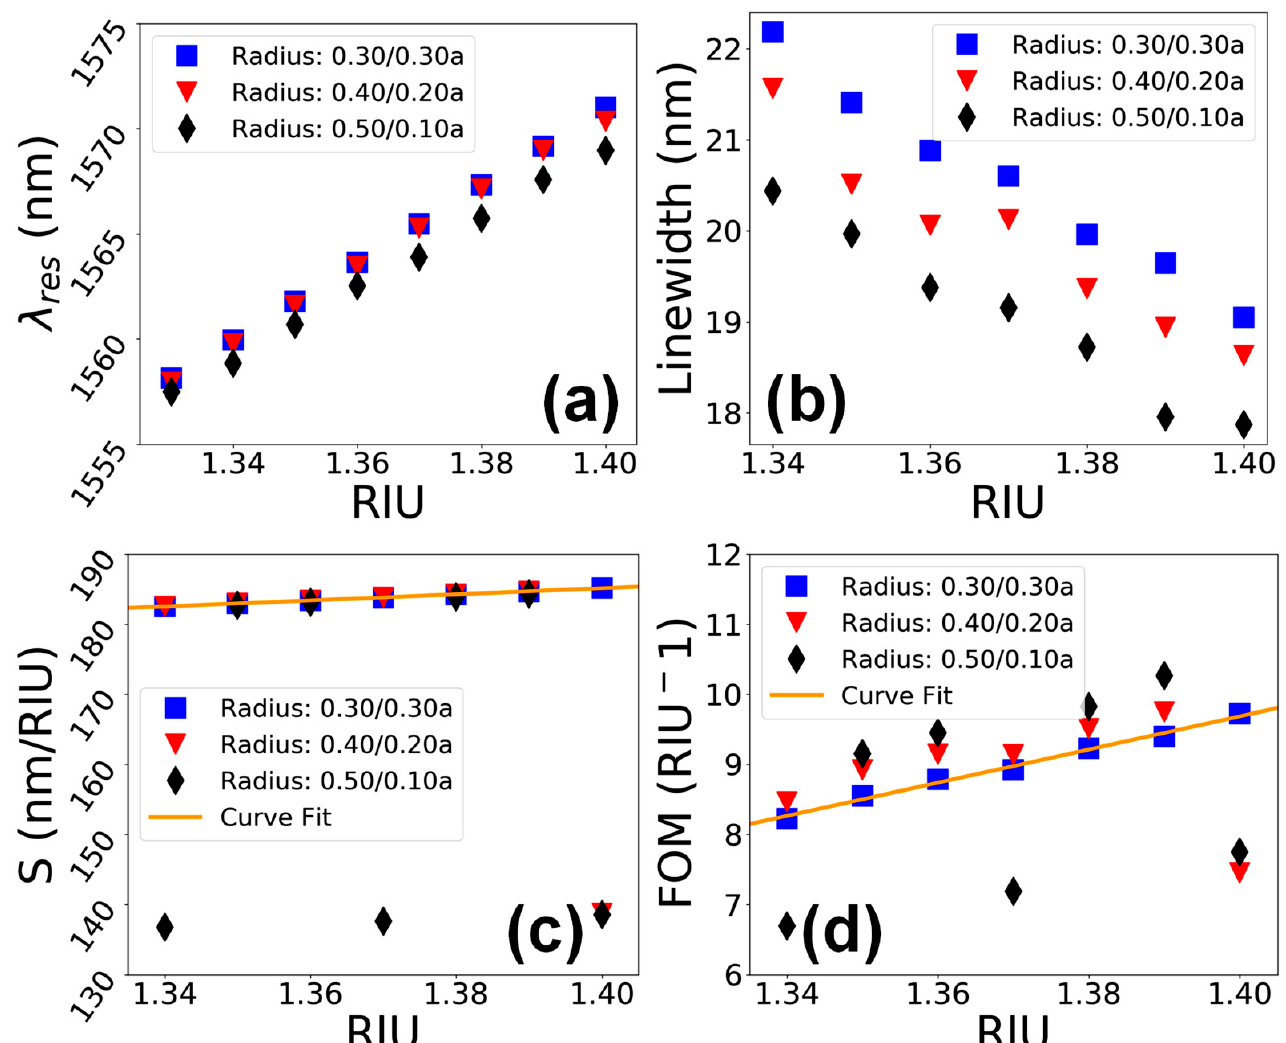
Figure 8. Performance evaluation of the sensor device vs. variation in the shape of PhC elements for a hole depth of d = 0.93 a . ( a ) λ res vs. RIU. ( b ) Linewidth vs. RIU. ( c ) S vs. RIU. ( d ) FOM vs.